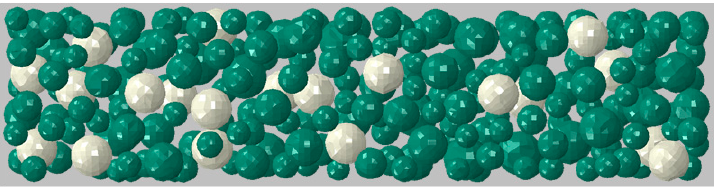
Figure 13. The side view of the internal structure of a meso-beam (transparent mortar matrix).